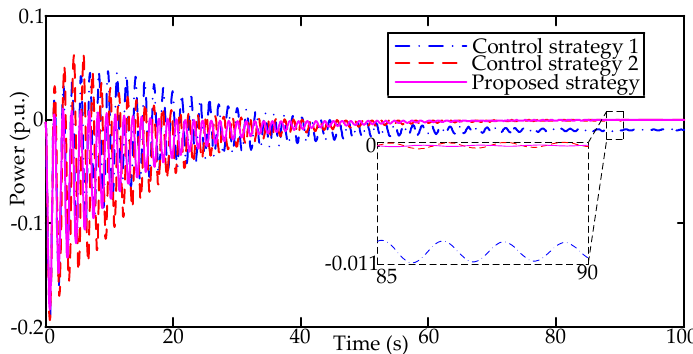
Figure 20. The tie-line power between Area 1 and Area 2 .